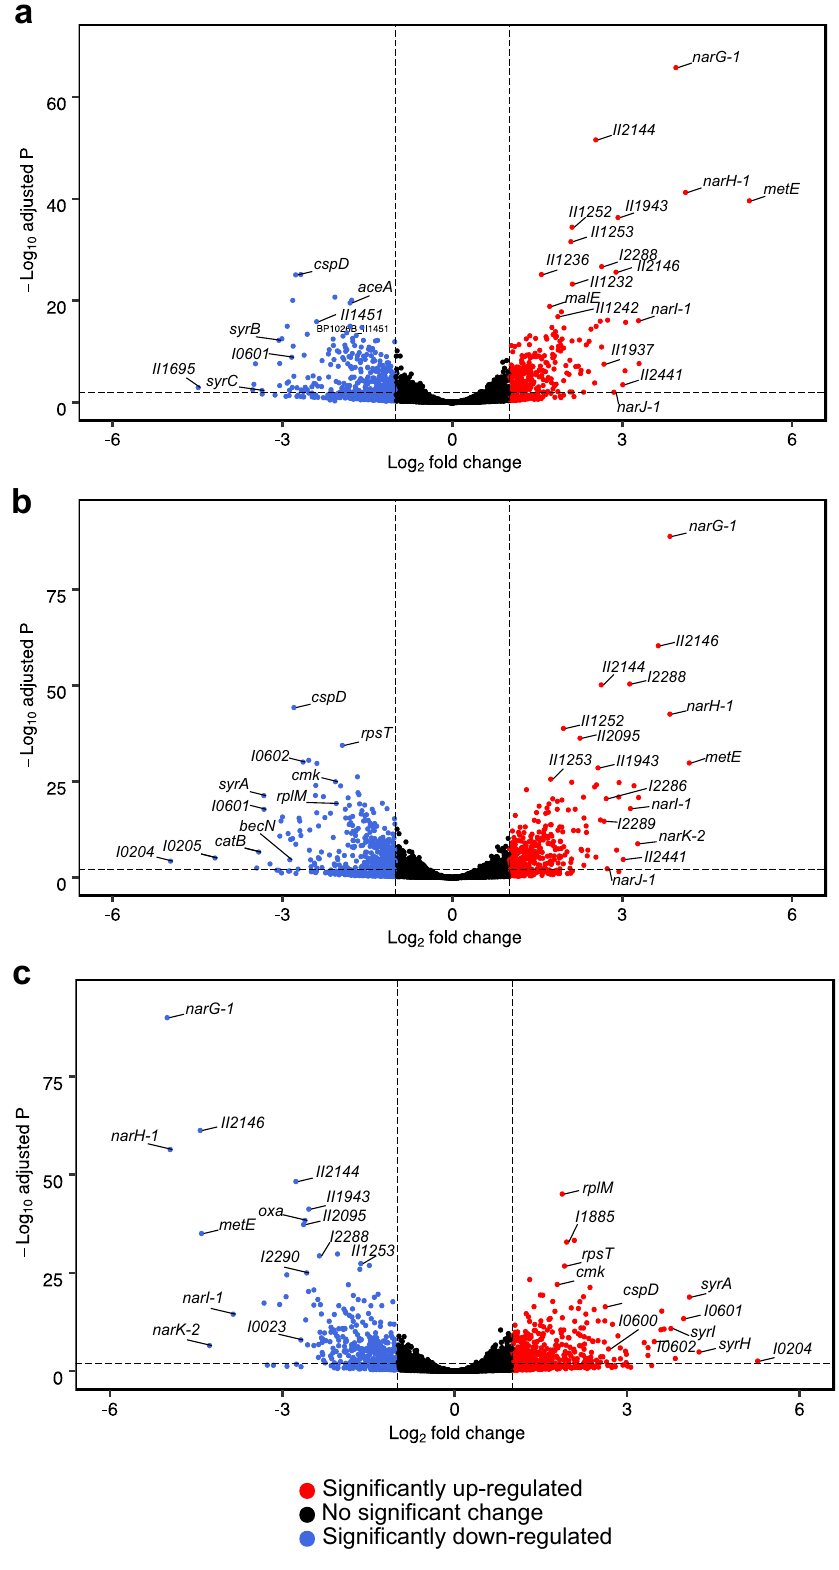
Figure 3. Trends in transcript fold changes in relation to statistical significance for comparably regulated datasets under nitrosative stress are reversed in the Δ narX mutant. NO 3− vs. Control ( a ) and NO 2− vs. Control ( b ), and Δ narX vs. wild type in the NO 3− condition ( c ). The control condition is un-supplemented LB media. Transcripts are depicted as colored circles; unchanged or middle expression (black), upregulated or high expression (red), downregulated or low expression (blue). Log 2 fold change values are distributed along the X-axes and Log 10 adjusted p-values (as determined by the Wald test) are distributed along the